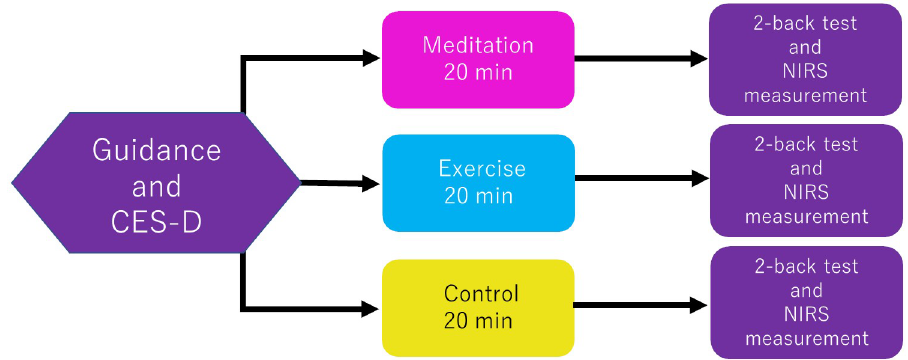
Fig 1. Experimental protocol. First, the CES-D was administered to the participants, and then 3 tasks: meditation, exercise, and a control task, were performed by the participants in a randomly selected order. After each task, a 2-back test was administered while the NIRS measurement was simultaneously